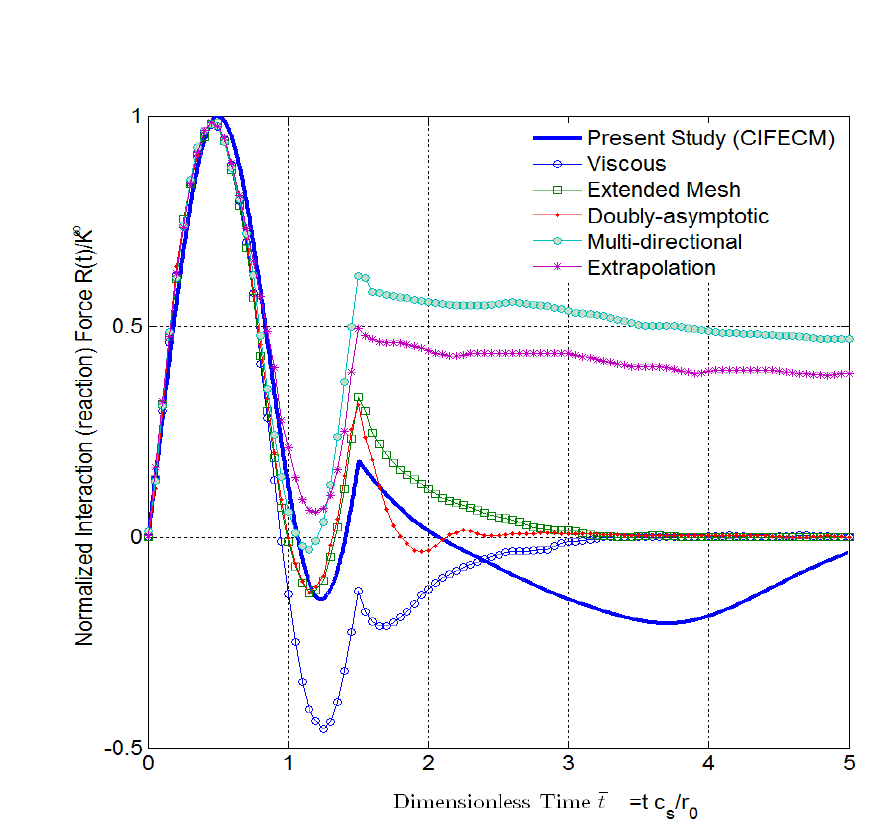
Figure 7. The time history of the reaction force R(t) at the top node.